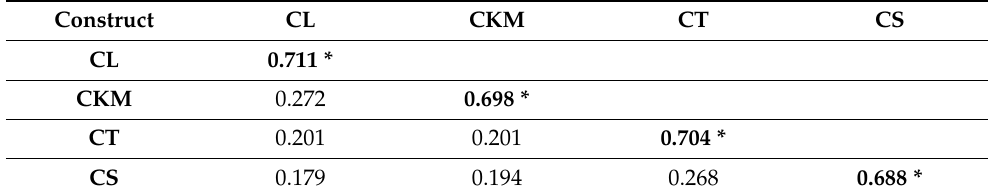
Table 5. Test of discriminant validity.